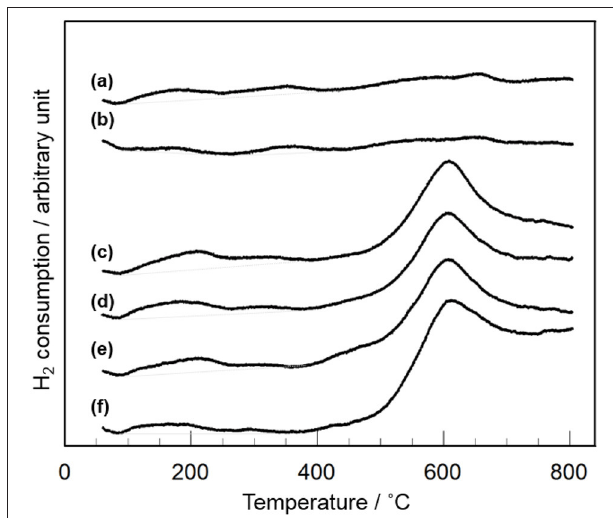
FIGURE 7 | H 2 -TPR profiles of CeO 2 ( x )/Y 2 O 3 (CP) with different CeO 2 loading. (a) Y 2 O 3 , (b) CeO 2 ( 1 )/Y 2 O 3 (CP), (c) CeO 2 ( 3 )/Y 2 O 3 (CP), (d)